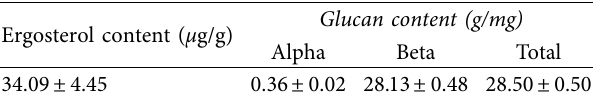
Table 8: Ergosterol and β -glucan content of shiitake mushroom ( Lentinus edodes ).